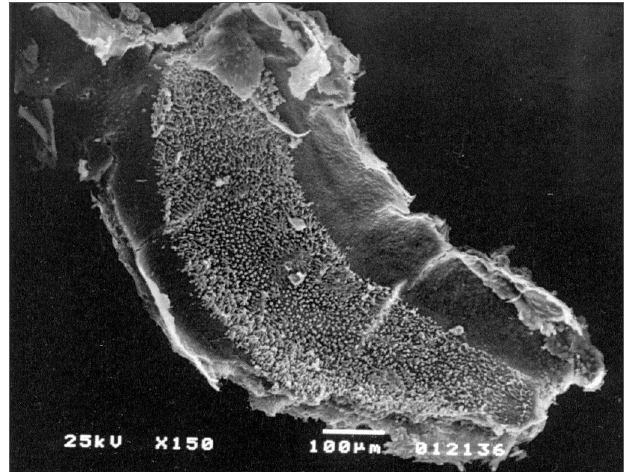
Figure 4. Crest of the lateral canal ampulla without alteration. Otosili- cate group - 30 days.